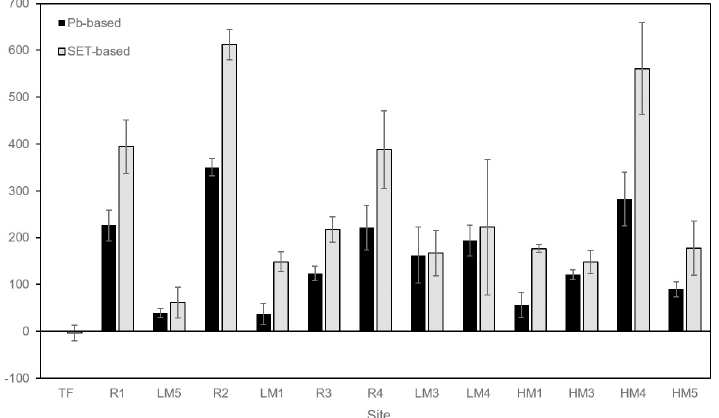
Fig 5. Carbon accumulation rates ( ± SE) from each site, with both 210 Pb-based and SET-based rates shown. Sites are arranged in order of increasing